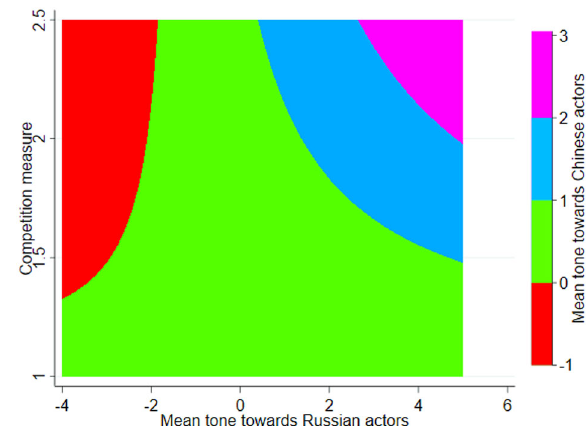
Fig. 3 Visualization of correlation between CoV-GCP and Narrative-GCP at the subregion level, including trendline.